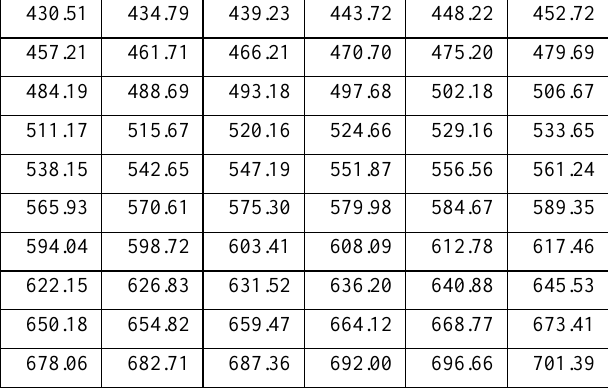
Table 2 Sentinel-2 band